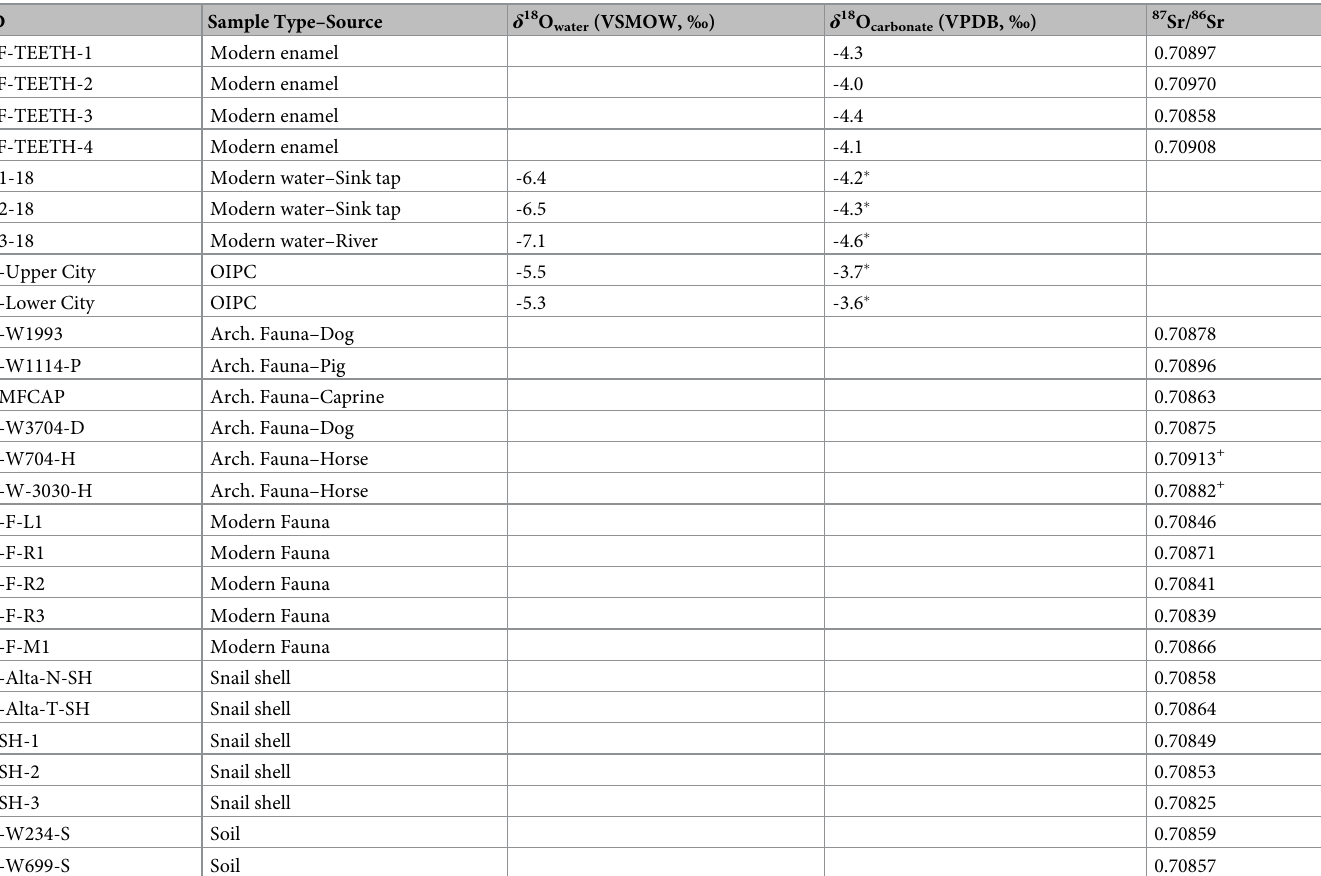
Table 1. Himera isotopic baseline.